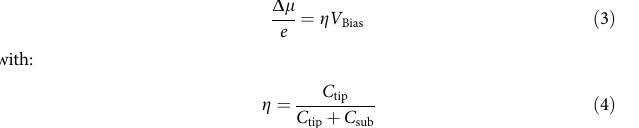
is extrapolated from high temperature and Fig. 4e. A line d E HT ext ð T Þ gives the temperature depen- the difference d E ð T Þ (cid:2) d E HT ext dence of the superconducting gap (Fig. 4f), which shows that the critical temperature T c C 6 K is smaller than the bulk value. The amplitude of the superconducting gap is obtained from D ¼ ð d E ð T ¼ 1 : 2 K Þ (cid:2) d E HT ð T ¼ 1 : 2K ÞÞ = 4. For this NC, the ext superconducting energy gap is about two times smaller than the bulk value, D ¼ D bulk /2.